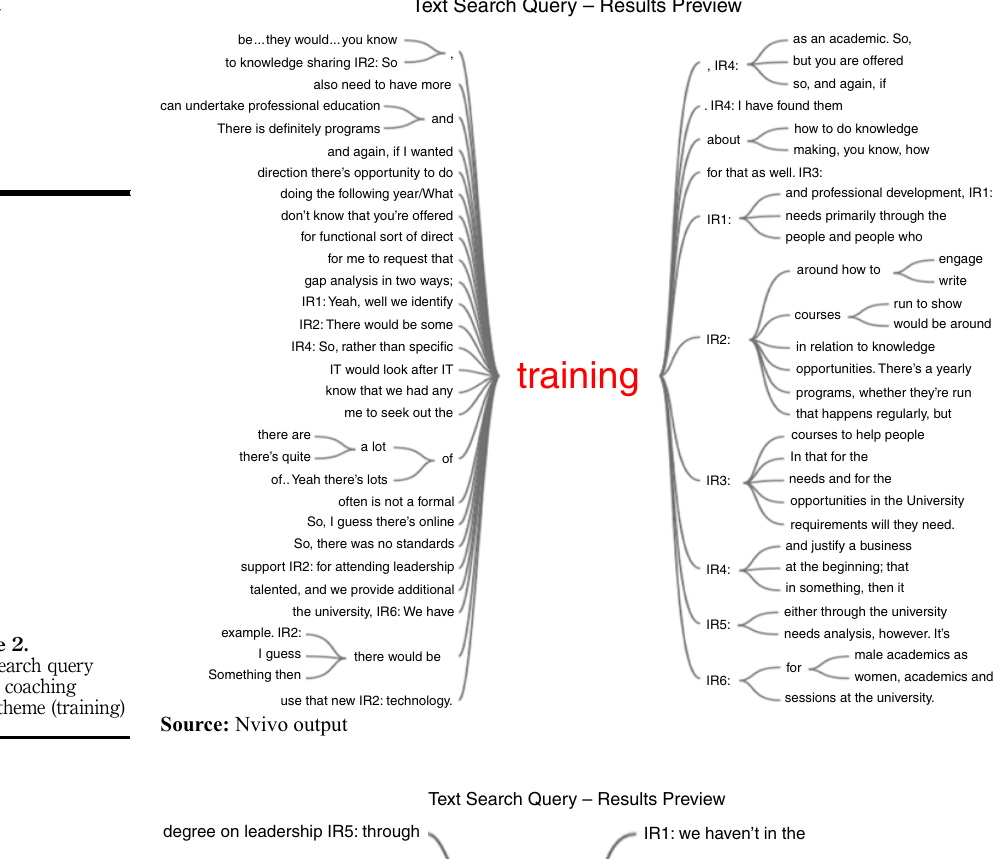
Figure 3. Text search query